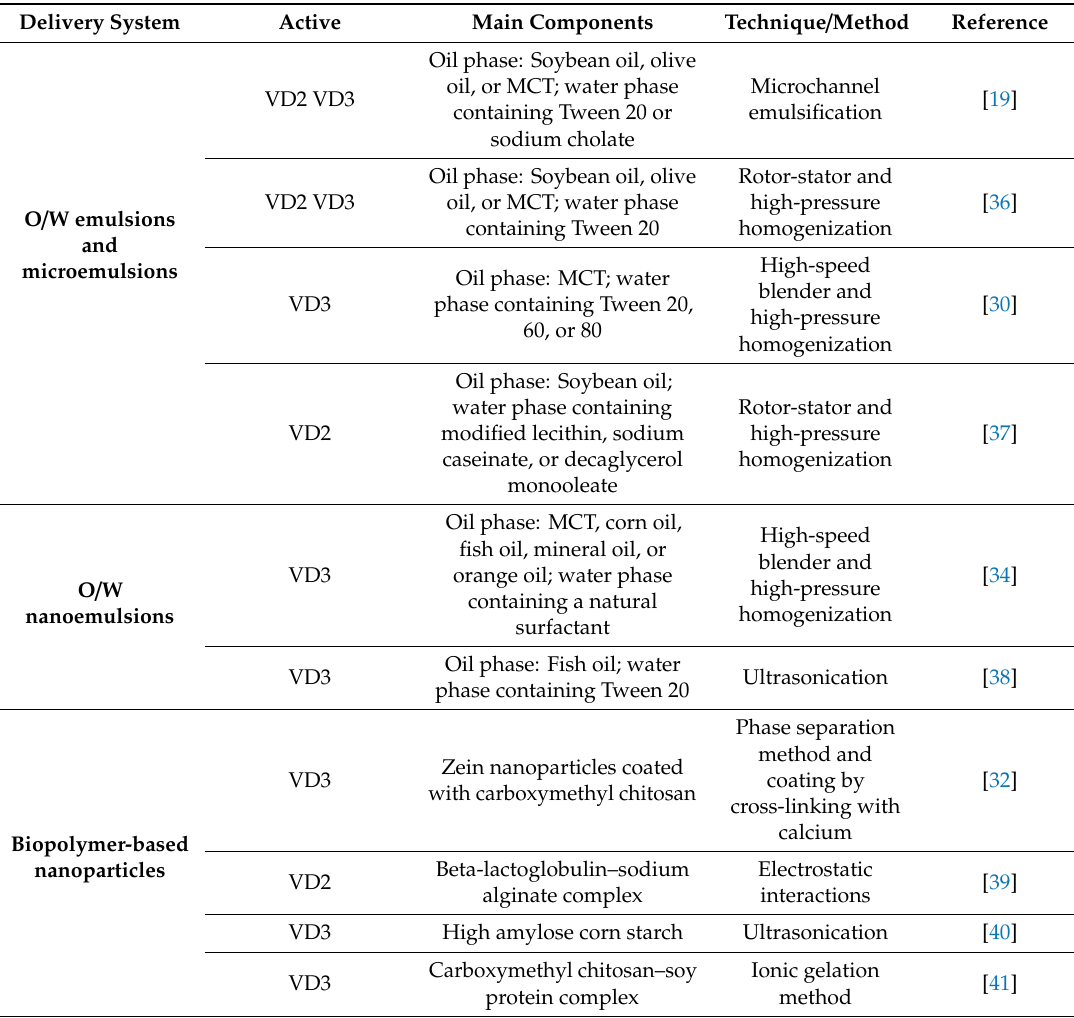
Table 1. Examples of various types of delivery systems reported for vitamin D encapsulation for potential use in food and beverage fortification (VD2—vitamin D2, VD3—vitamin D3, MCT—medium chain